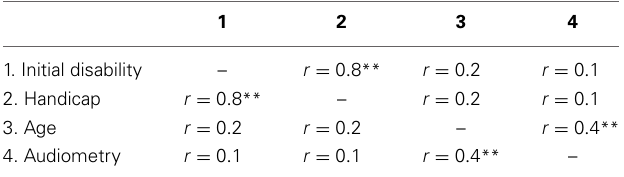
Table 1 | Results of Pearson correlation for pre-fitting assessment GHABP.